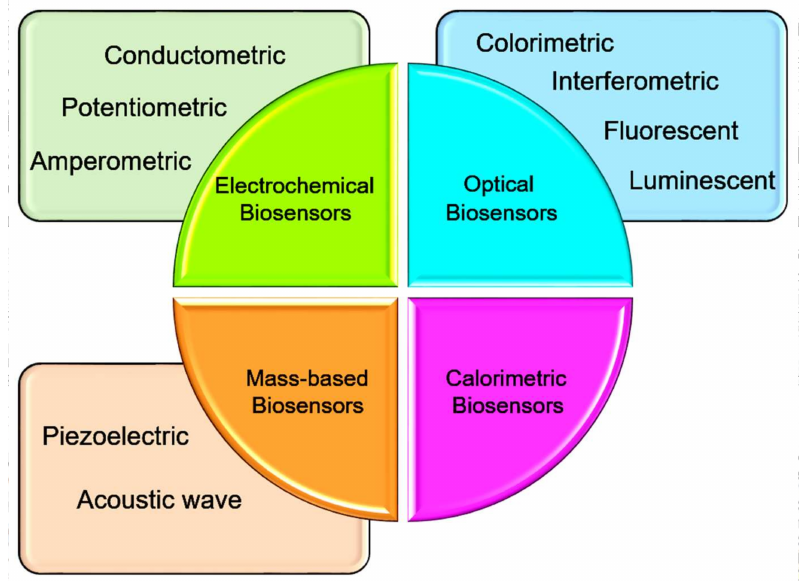
Figure 2. Four different classes and sub-classes of biosensors based on the type of